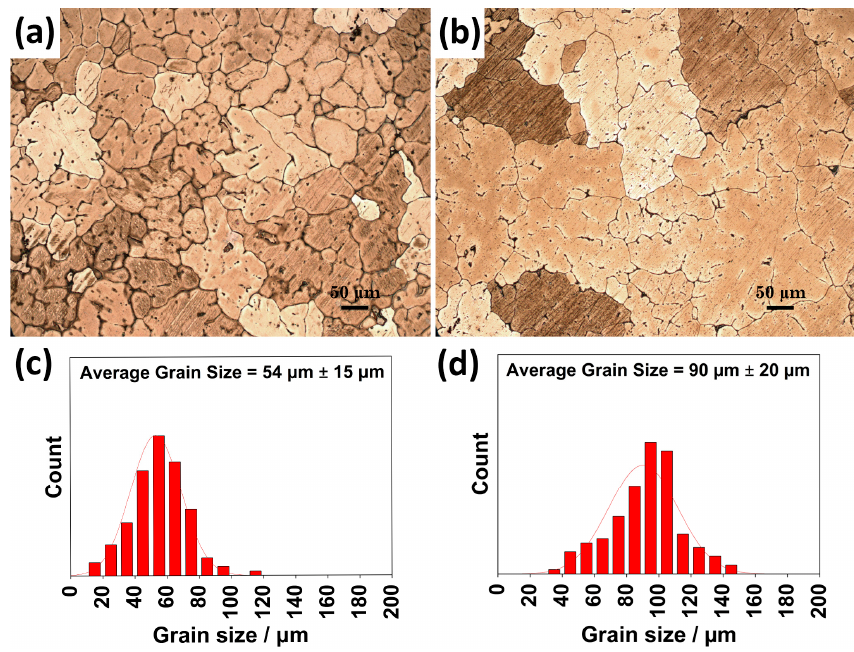
Figure 3. Optical micrographs and grain size distributions of ( a , c ) as-cast and ( b , d ) homogenized alloys.